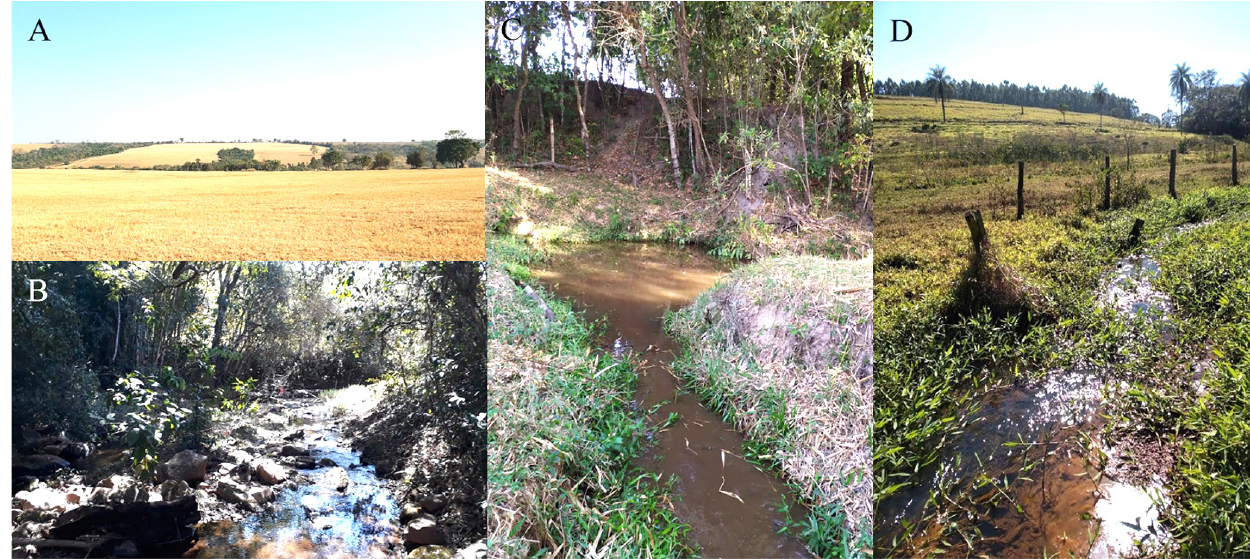
FIGURE 2 | Examples of landscape and local-habitat conditions of the streams sampled across a degradation gradient in the Cerrado: A. Streams with a small strip of riparian forests in landscapes dominated by mechanized agriculture; B. Stream with relatively well-preserved local conditions, including forest on both banks; C. Stream surrounded by intermediate riparian cover; and D. Stream running in pasture areas without any